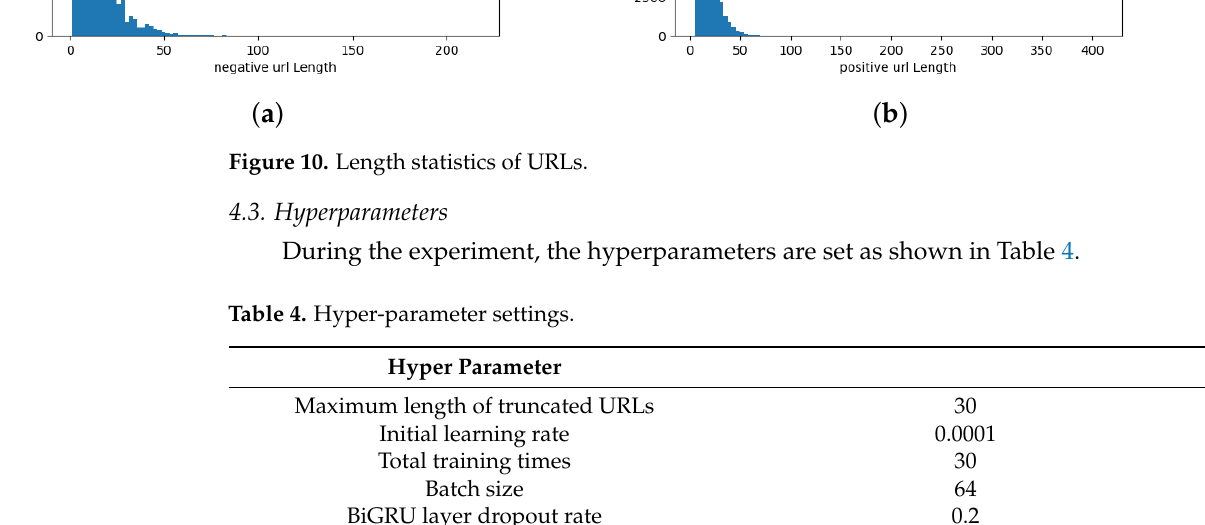
Figure 10. Length statistics of URLs.